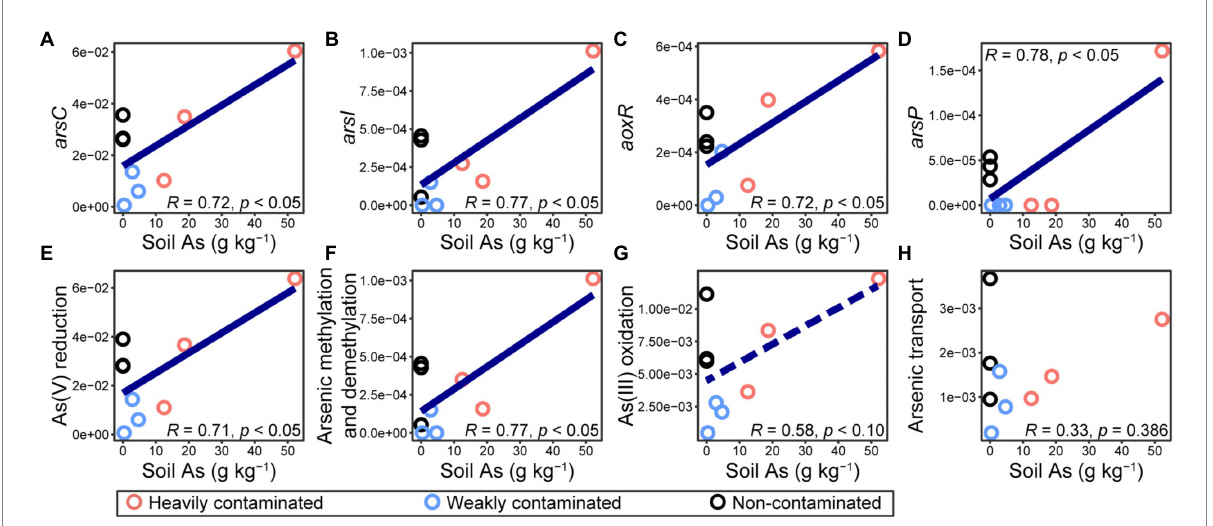
FIGURE 6 Normalized abundances (i.e., arsenic gene copy number per 16S rRNA gene) of (A–D) genes involved in microbial arsenic cycling and (E–H) different functional processes in Pteris vittata rhizosphere soil with different levels of arsenic contamination in the field. The abundance of (A) arsC , (B) arsI , (C) aoxR , and (D) arsP , which are involved in As(V) reduction, arsenic methylation, As(III) oxidation, and arsenic transport, respectively, were analyzed with a high-throughput qPCR chip (AsChip). The abundance of functional processes refers to the sum of abundances of all genes encoding four main arsenic biotransformation processes (i.e., arsenic methylation and demethylation, arsenic transport, As(III) oxidation, and As(V)